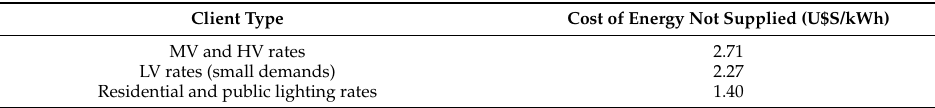
Table 15. Value of energy not supplied in